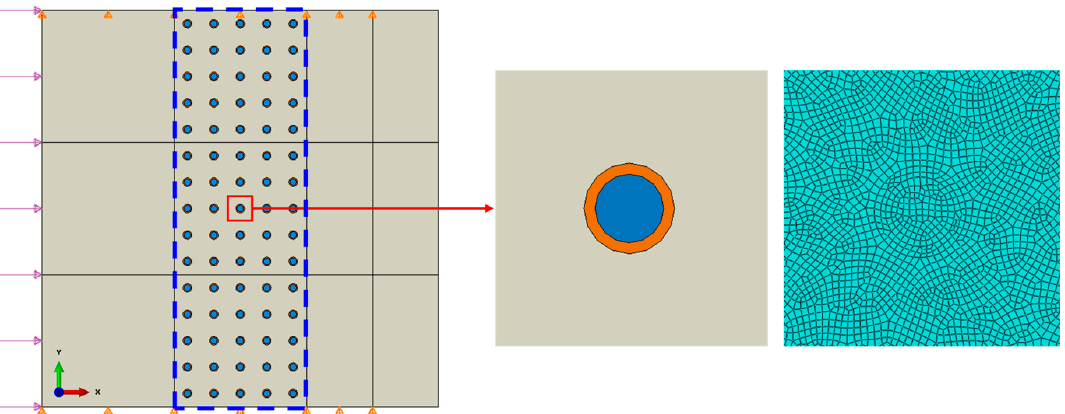
Figure 5. Schematic diagram of the FEM model of the composite embedded with multiple coated particles and the local zoom-in mesh diagram.